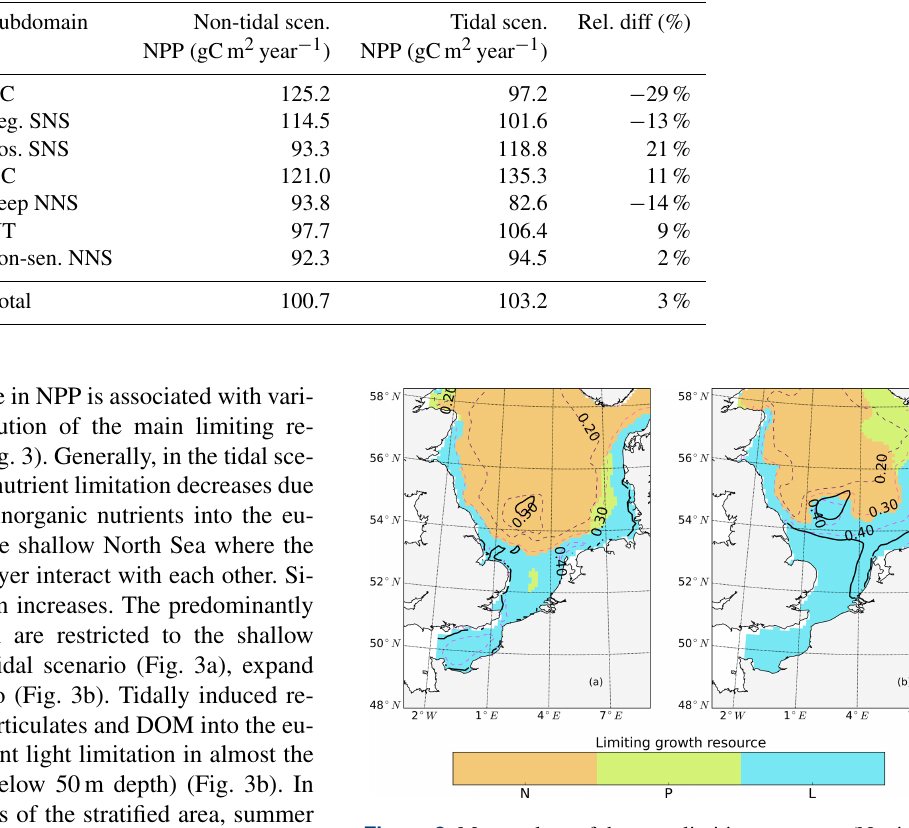
Figure 3. Mean values of the most limiting resources (N: nitrogen, P: phosphorus, L: light) in the surface layer for July (averaged for the analyzed period; 1990–2015) for the non-tidal scenario (a) and tidal scenario (b) . The limiting value (derived from Liebig’s law) is indicated by dashed contour lines. Stratified and unstratified areas are separated by black lines (for definition, see Fig.